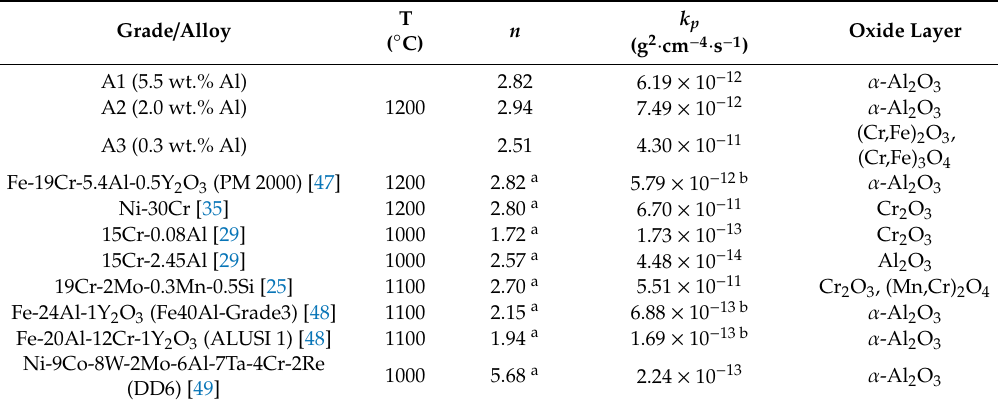
Table 2. The results of analyses of the weight gain and comparison with the literature data. Grade /